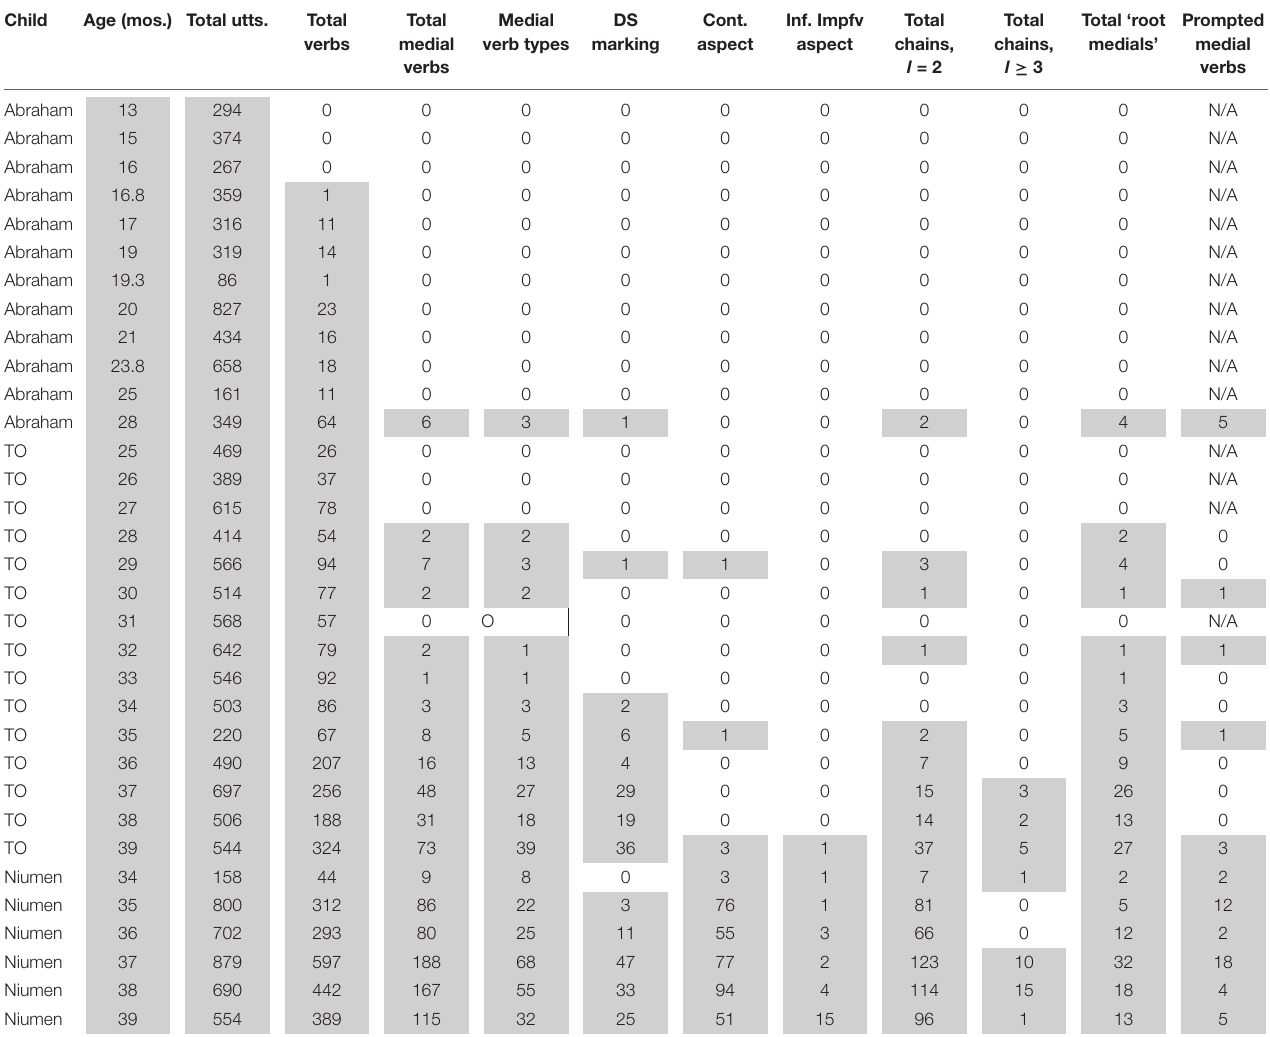
TABLE 1 | Counts of clause chain-related verb forms produced by target children. Child Age (mos.) Total utts. Total